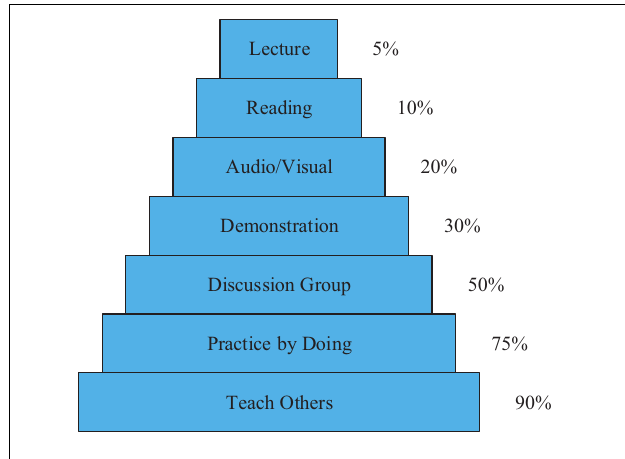
FIGURE 3 | Bloom’s cognitive hierarchy. FIGURE 4 | Knowledge